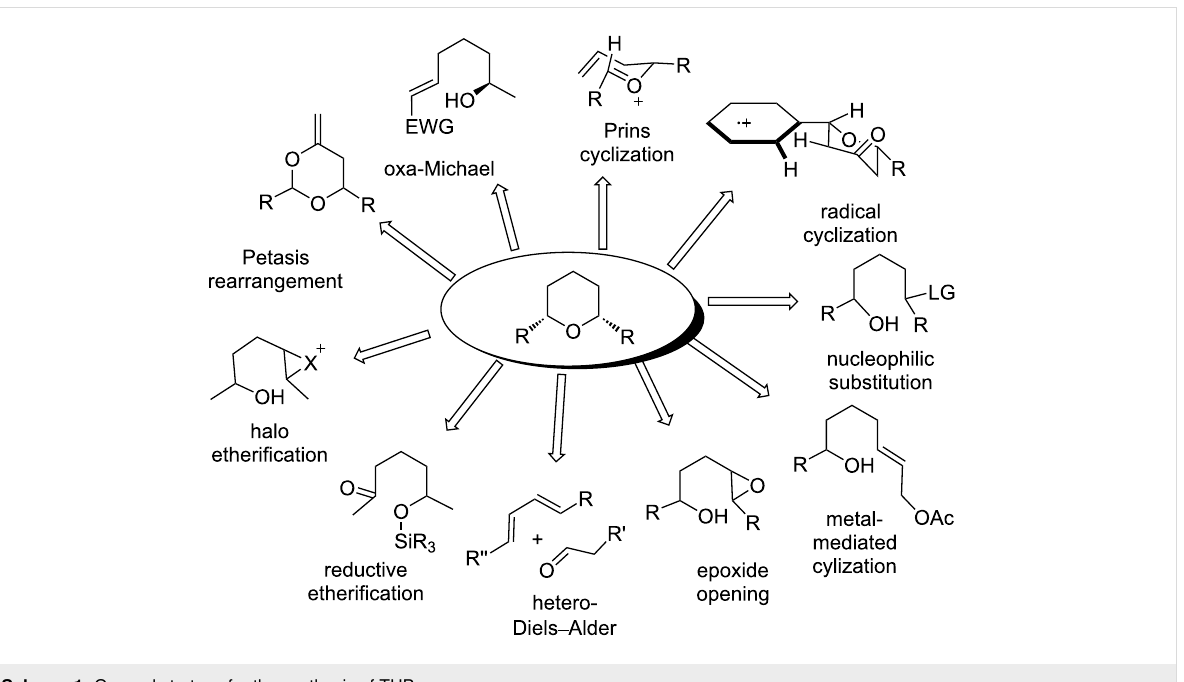
Scheme 1: General strategy for the synthesis of